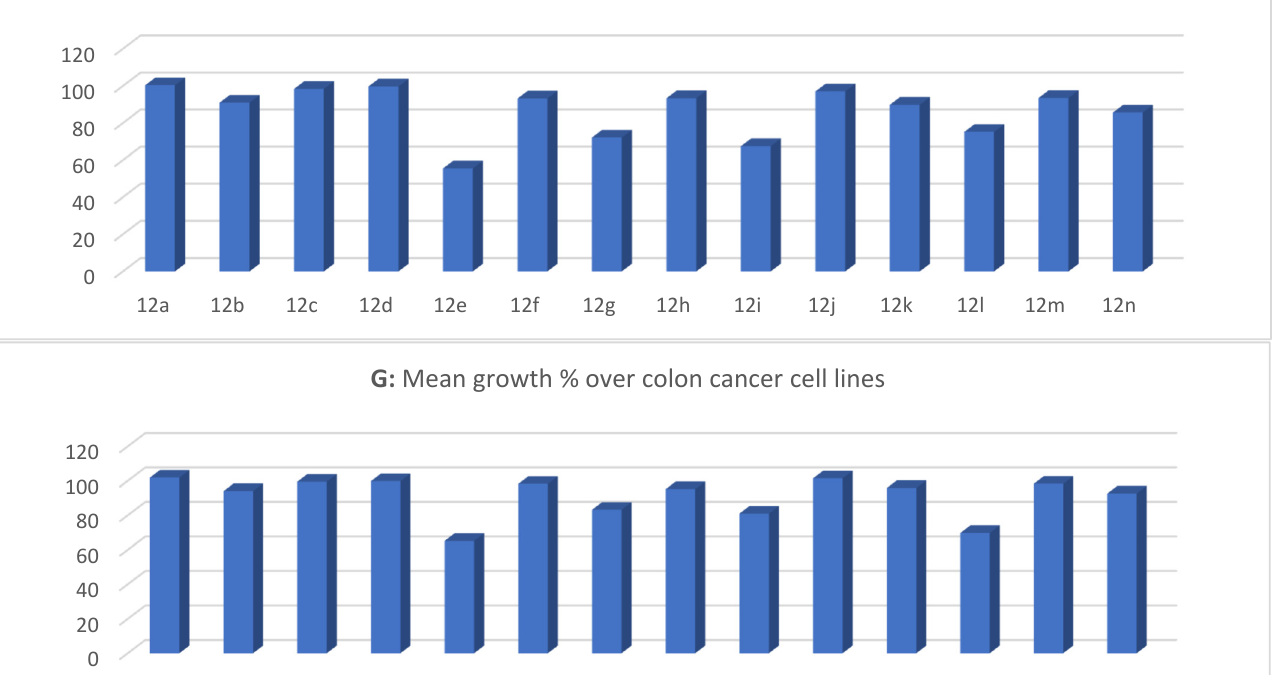
F: Mean growth % over melanoma cell lines